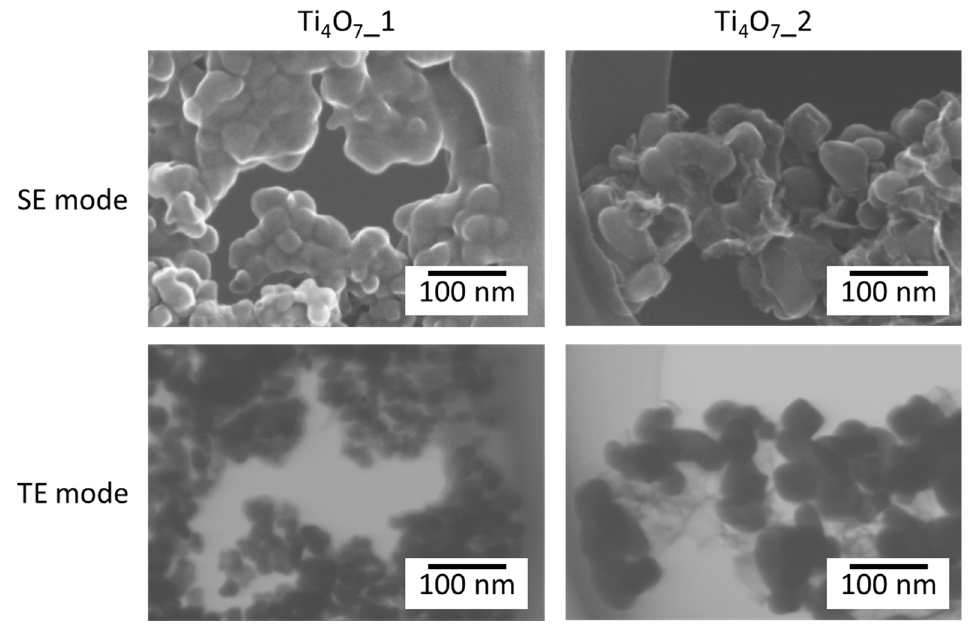
Figure 5. FE-SEM images of Ti 4 O 7 _1 and Ti 4 O 7 _2 acquired in SE and transmission electron (TE) mode.